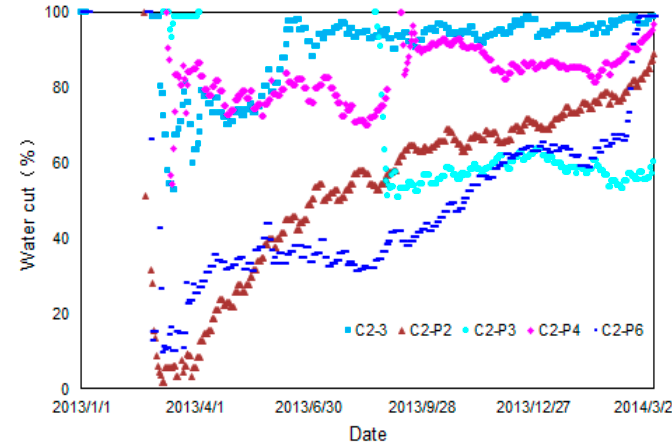
Figure 35. Water-cut curve of effective wells .